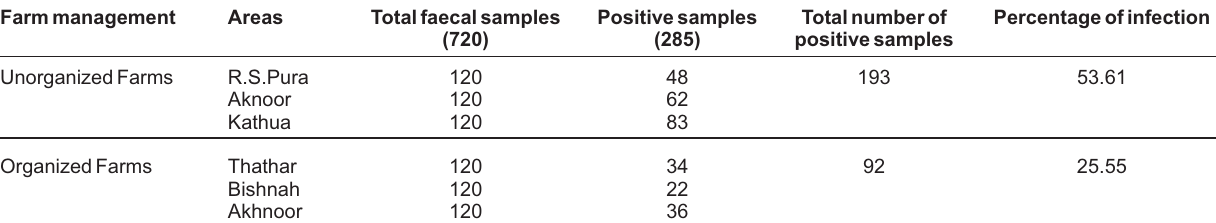
Table-1. Prevalence of chicken coccidiosis in organized and backyard farms in Jammu